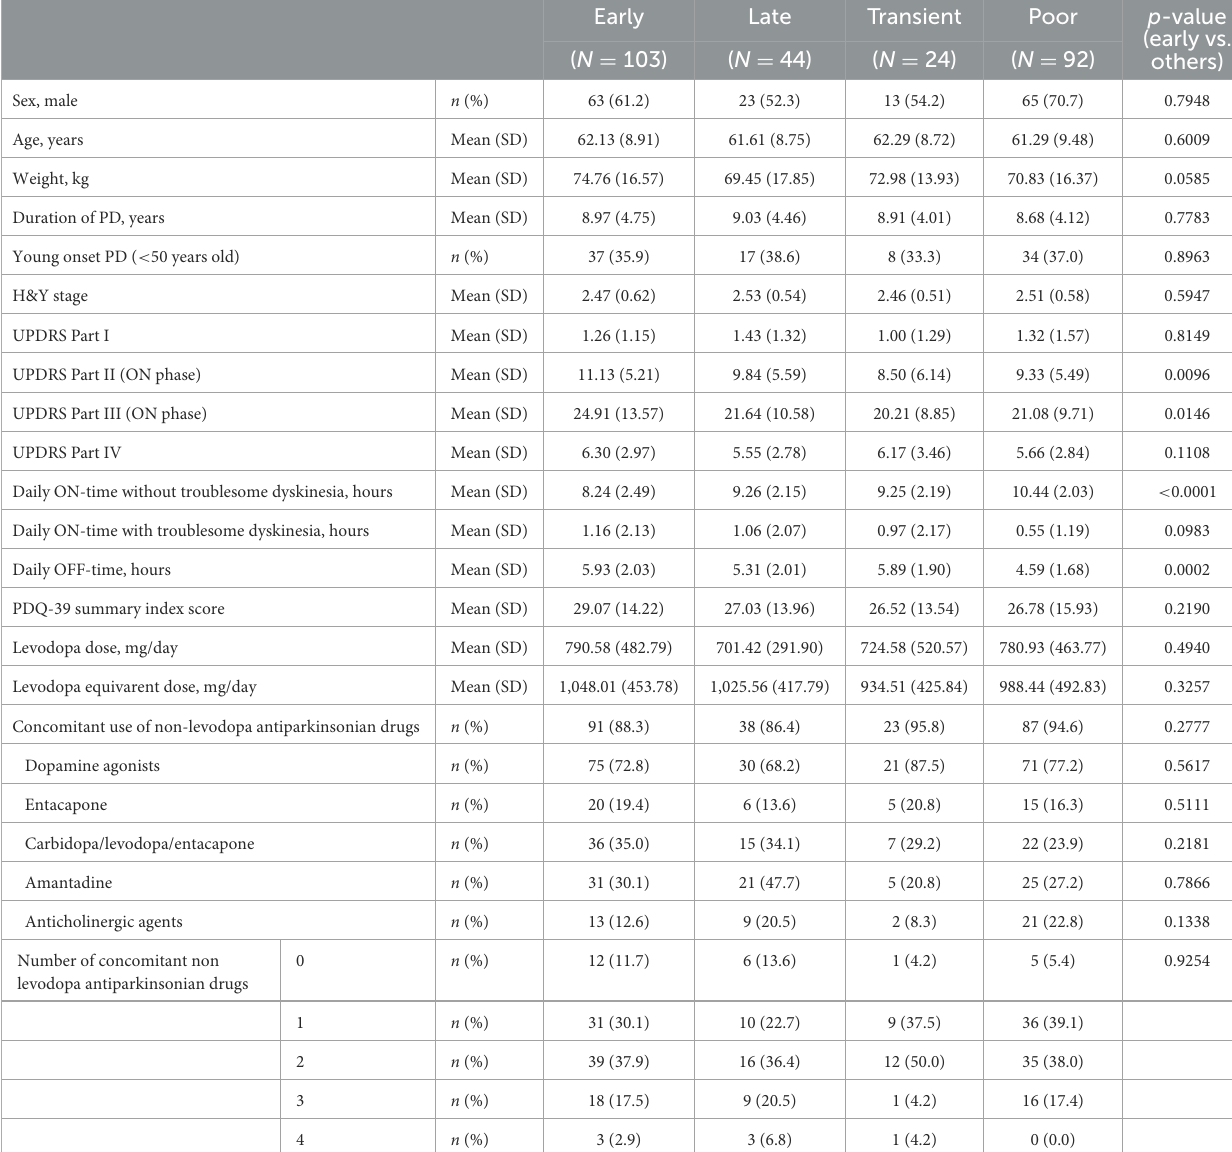
TABLE 1 Demographic and baseline characteristics by responder subgroup in the safinamide group.